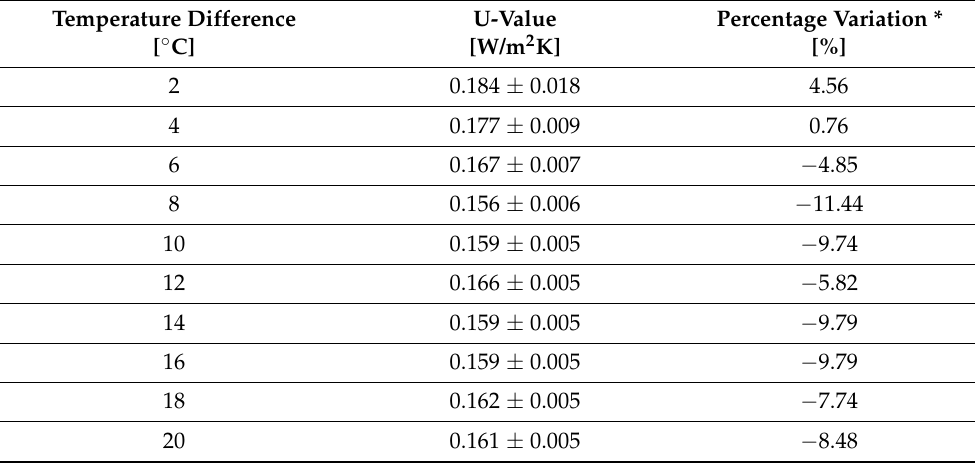
Figure 4. Thermal transmittance values found as a function of the temperature differences obtained in the GHB. Table 4. Thermal transmittance values and percentage variations for the different